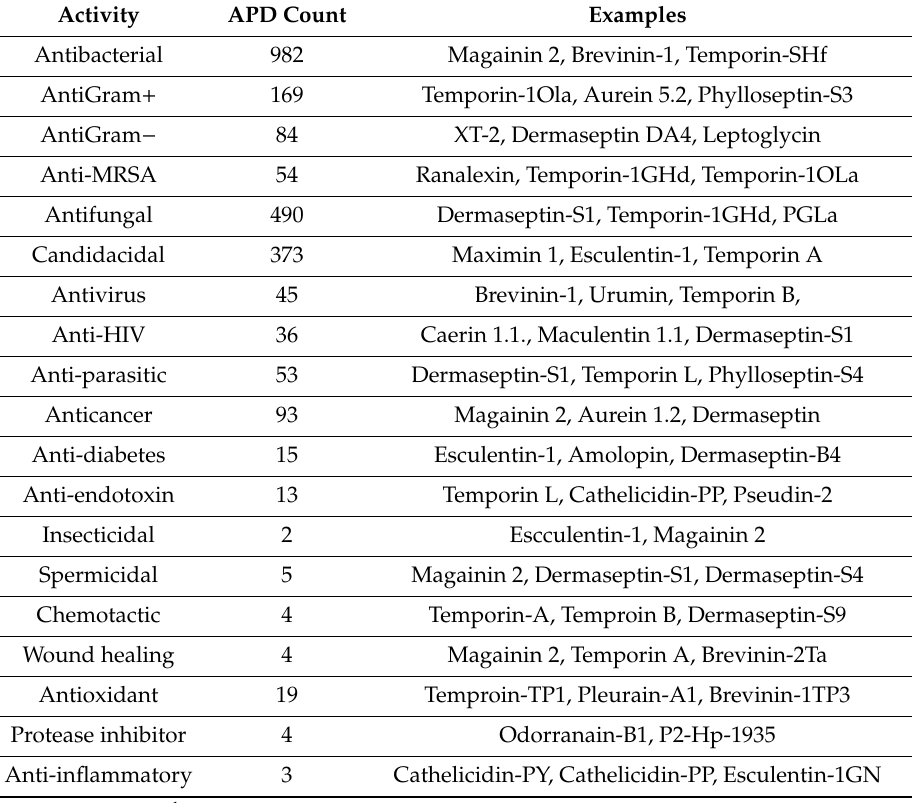
Table 2. Amphibian antimicrobial peptides possess diverse activities 1